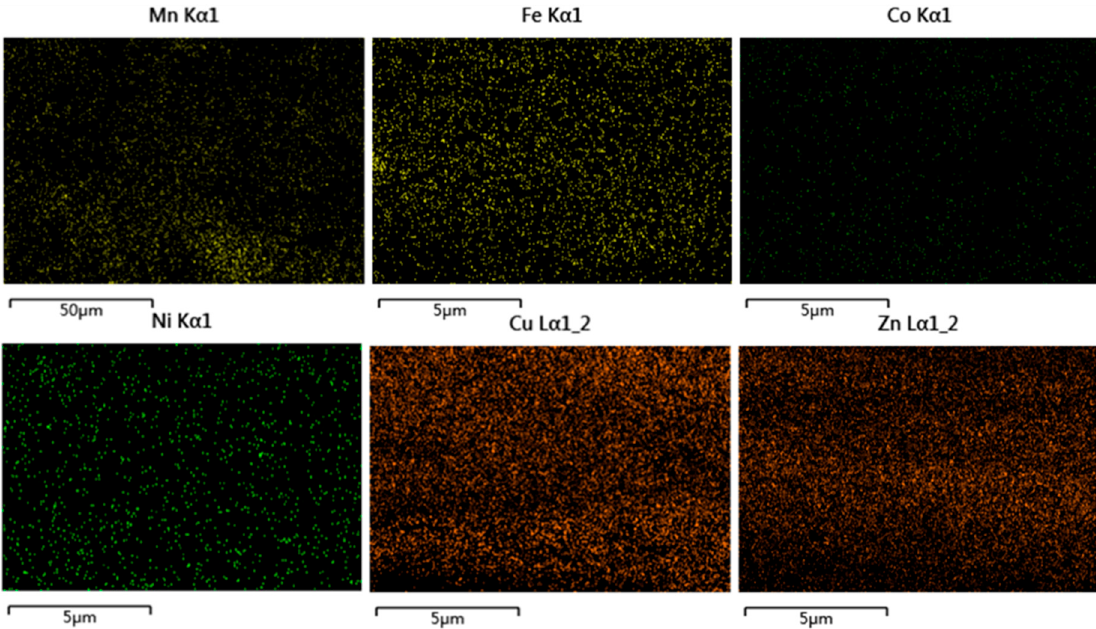
Figure 4. Energy dispersive X-ray spectroscopy (EDS) images of F8bpy/metal/SWCNT composites films with different transition metal ions.